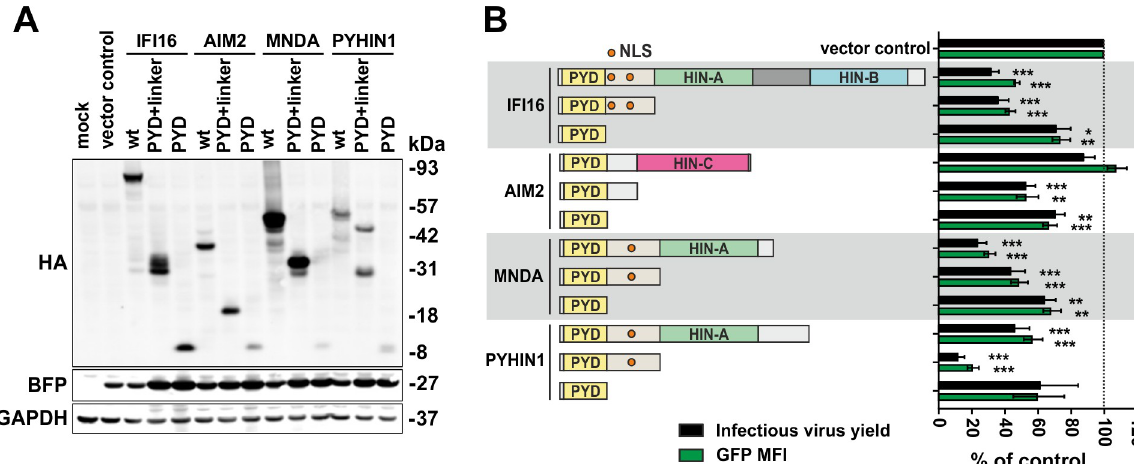
Fig 5. Determinants of the antiretroviral activity of human PYHIN proteins. (A) HEK293T cells were transfected with constructs coexpressing the indicated full-length (wt) form of IFI16, PYHIN1, MNDA and AIM2 or just the N-terminal PYD or PYD and linker region and BFP or a vector control and expression was analyzed by Western blot. BFP and GAPDH are used as transfection and loading control, respectively. (B) Effect of mutant PYHIN proteins on infectious virus yield (black) and levels of LTR-dependent eGFP expression (green). HEK293T cells were cotransfected with constructs coexpressing the indicated wt and mutant PYHIN proteins and proviral HIV-1 NL4-3 IRES- eGFP constructs. At 40 hours post-transfection, BFP and eGFP expression was analyzed by flow cytometry. Shown are mean values ( ± SEM) derived from seven experiments relative to those obtained in the presence of the empty control vector (100%). � p < 0.05, �� p < 0.01, ��� p < 0.001.